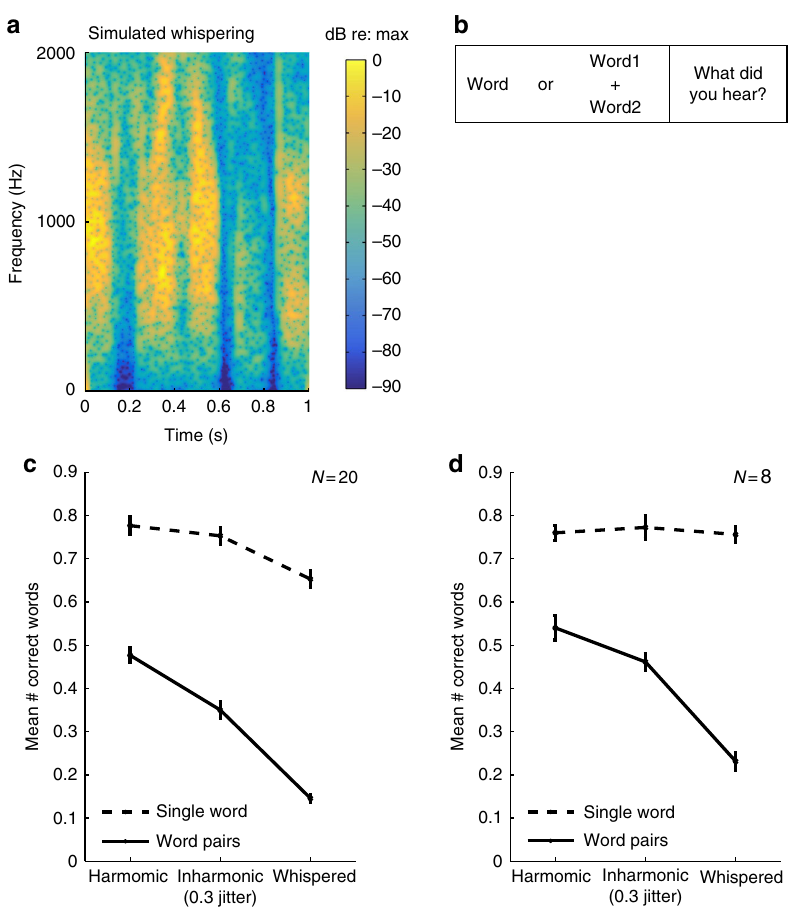
Fig. 5 Effect of noise excitation, simulating whispering (Experiment 4). a Spectrogram of utterance from Fig. 3a resynthesized with noise excitation. b Schematic of task. c Intelligibility of mixtures of harmonic, inharmonic, and noise-excited words, along with that of single words in quiet for each condition. Here and in d , error bars denote SEM. d Intelligibility of mixtures of harmonic, inharmonic, and noise-excited words after equating intelligibility of single words in